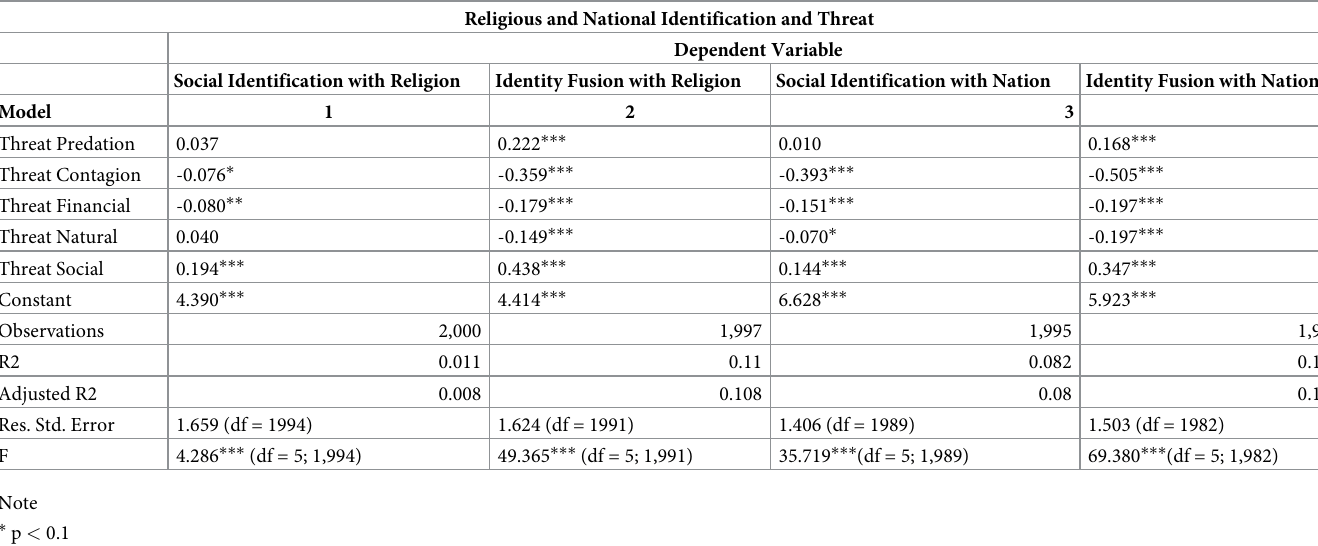
Table 5. Predicting levels of religious and national social identity (sid) and identity fusion (ift) as functions of social